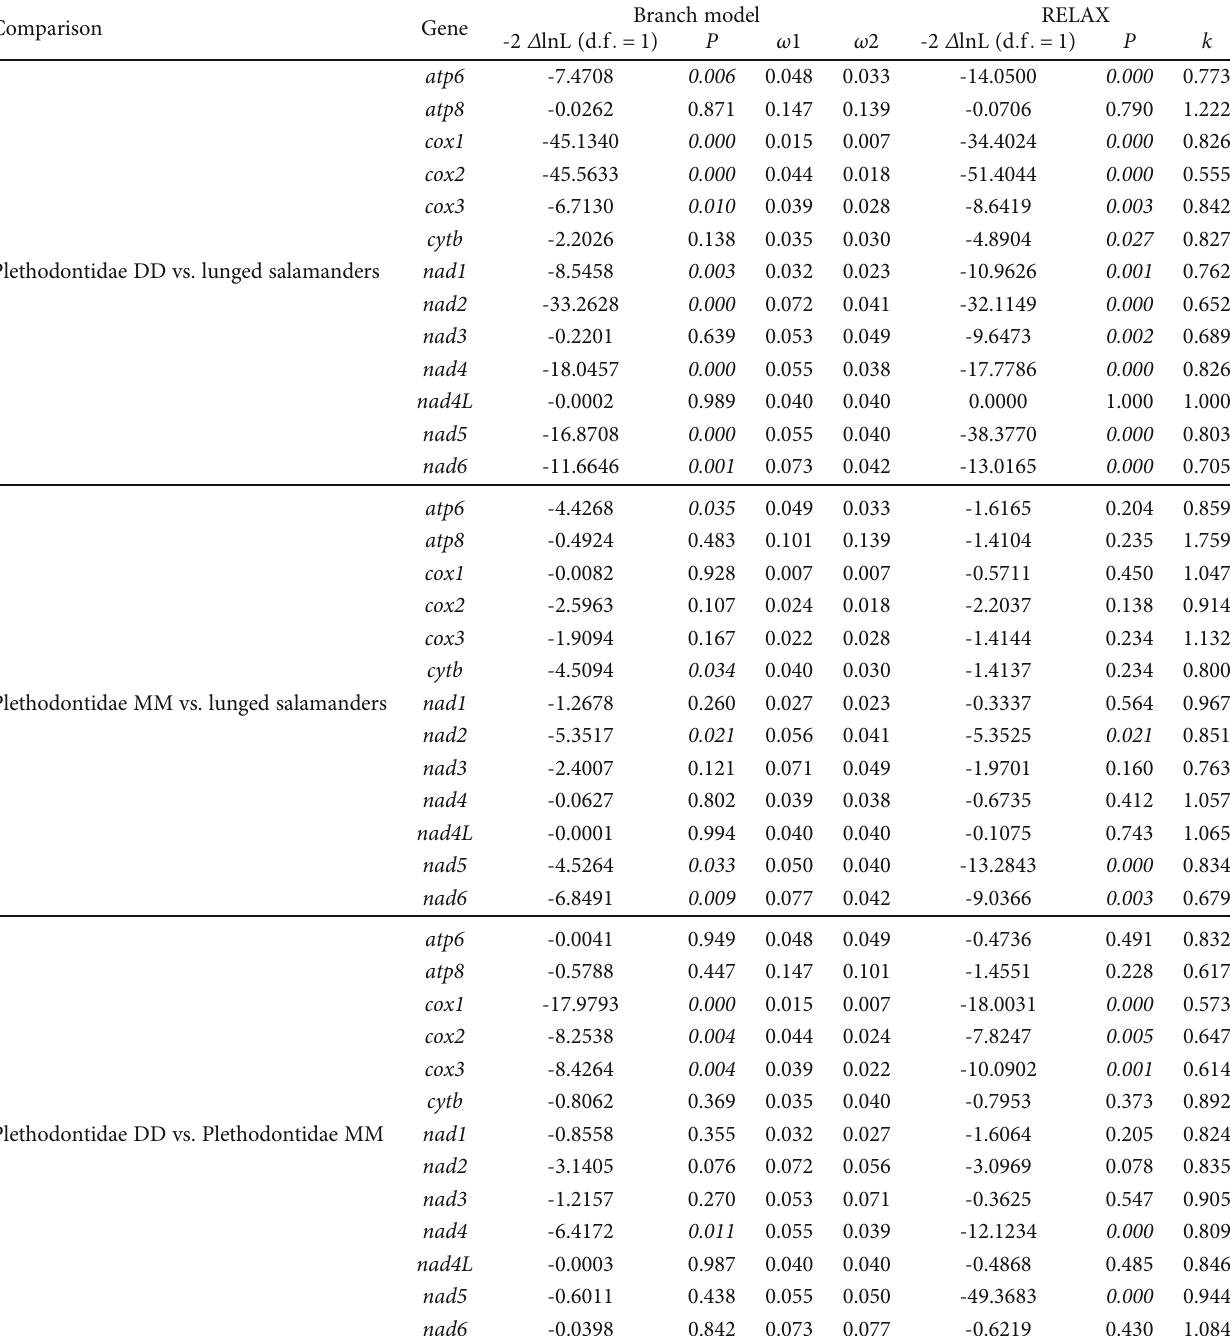
Table 2: Results of branch model and RELAX analyses of mitochondrial genes without internal branches.